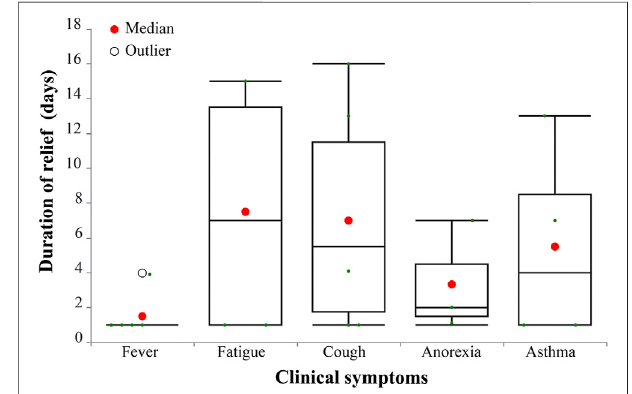
FIGURE 4 | Longitudinal course of clinical symptoms in eight COVID-19 cases.